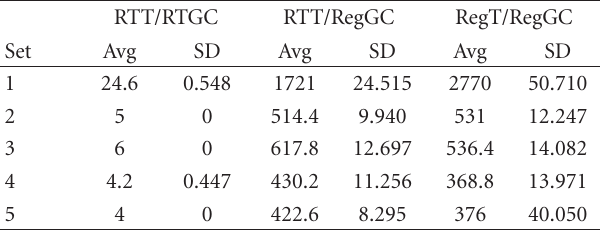
Table 3: Experimental results showing the average number of times the garbage collector executed along with the standard